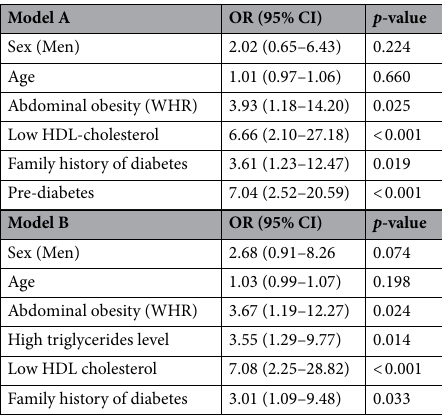
Table 3. Multivariate binomial logistic regression models to assess the contribution of different variables in diabetes prediction. The starting model A included all variables with p < 0.2 in the univariate analysis. In model B, the same variables were included, except for the pre-diabetes status at baseline and the HOMA-IR index. The two models were built manually. At each step of the modelling process, we repeatedly removed the variable with the highest p -value and we tested the model again until all remaining variables were significant ( p < 0.05). Age and sex, regardless of their statistical significance, were kept in the final model. Family history of diabetes defined as 1st or 2nd degree relatives with diabetes. Definitions of the rest of cardiovascular risk factors are detailed in